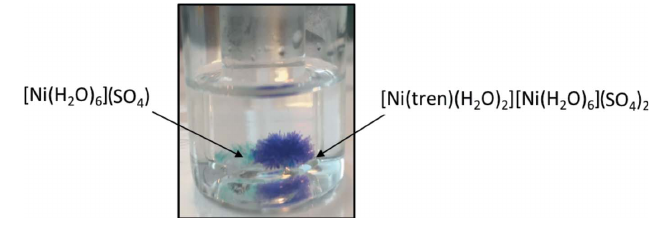
Figure 4 Crystallization of [Ni(tren)(H 2 O) 2 ][Ni(H 2 O) 6 ](SO 4 ) 2 and [Ni(H 2 O) 6 ]SO 4 in the same reaction